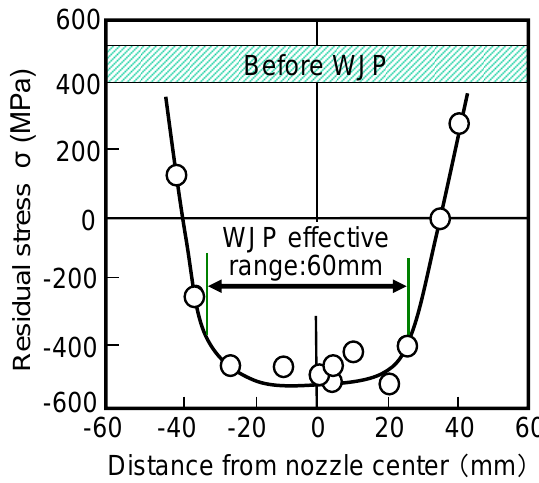
Figure 4. Residual stress distribution on a type 304 stainless steel plate surface measured by X-ray diffraction.